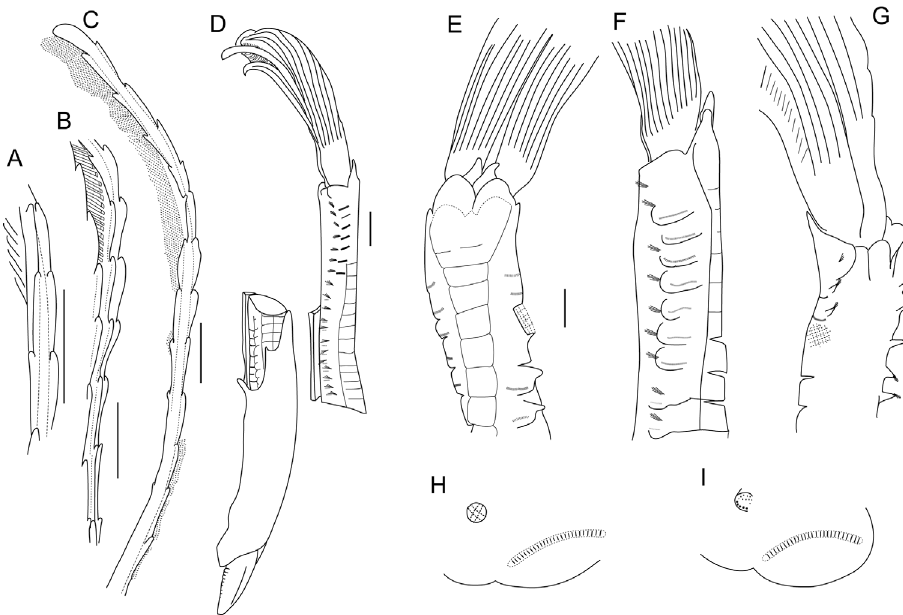
Figure 6. Pseudobranchiomma orientalis Type BMNH 85.12.1.393. Line drawings by Phyllis Knight- Jones. A–C Second dorsal radiole from different views D Holotype, divided in two, and partially cov- ered by the tube, lateroventral view E Base of crown and anterior thoracic chaetigers, ventral view F Same, lateral view G Same, dorsal view H Thoracic parapodium I Abdominal parapodium. Scale bars: A–C = 1 mm; D = 2 mm; E–G = 1 mm; H–I =